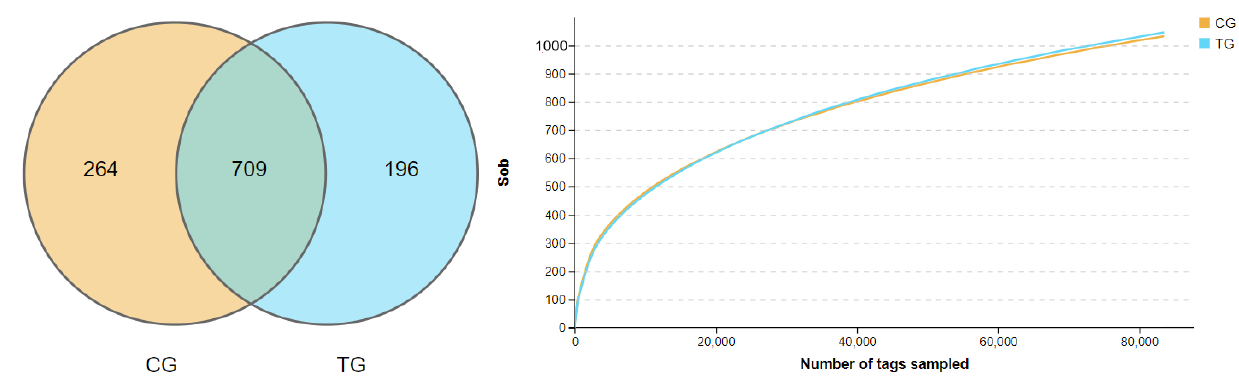
Figure 2. ( A ) Venn maps of OTUs. ( B ) The rarefaction curves of observed species. CG (control group), TG (treatment group of 35 ppm ammonia).